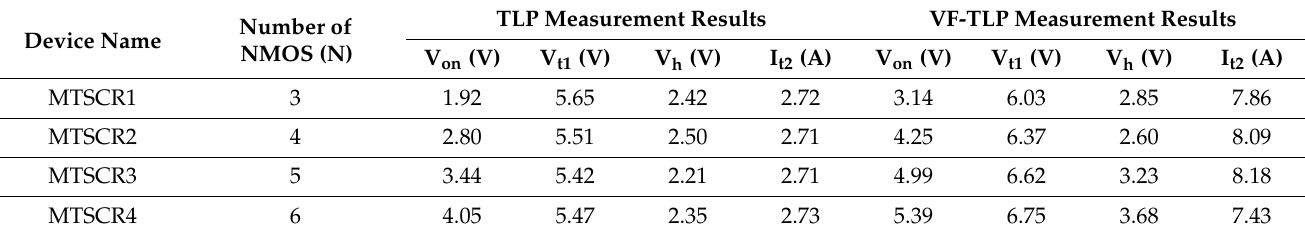
Table 1. TLP and VF-TLP test results of MTSCRs.